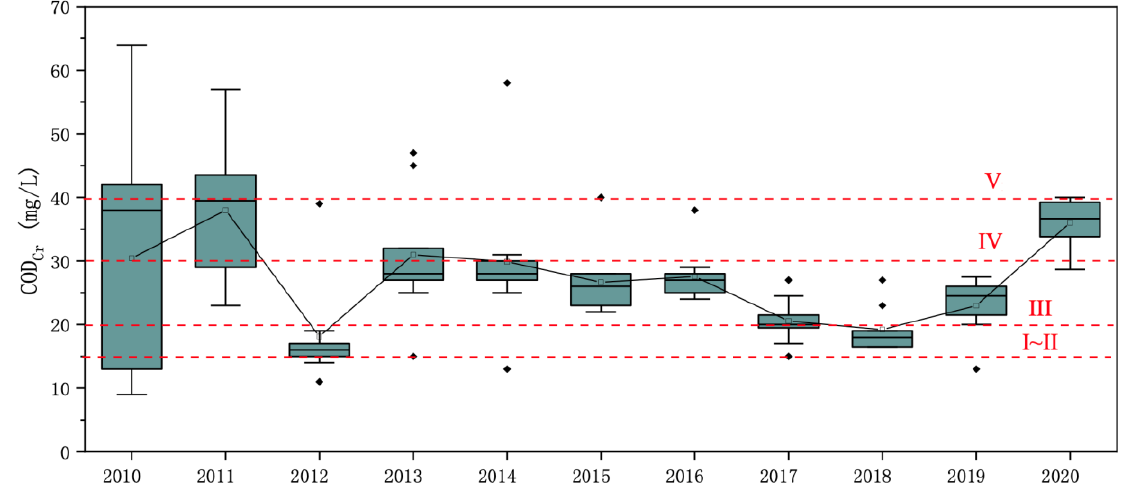
Figure 4. Change trend of COD Cr in Qinghai Lake from 2010 to 2020.